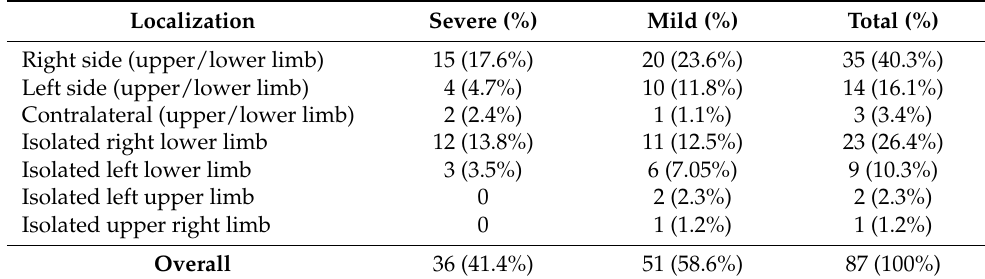
Table 1. Distribution of lateralized overgrowth by severity and